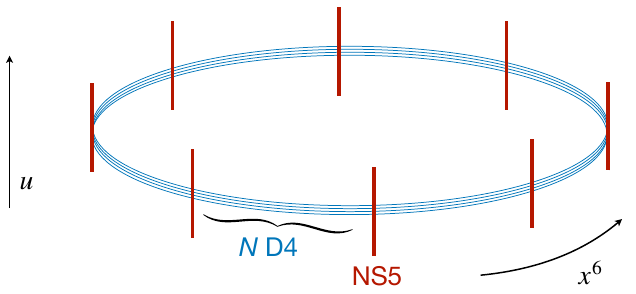
) groups starting with a ‘1’. We will use this c